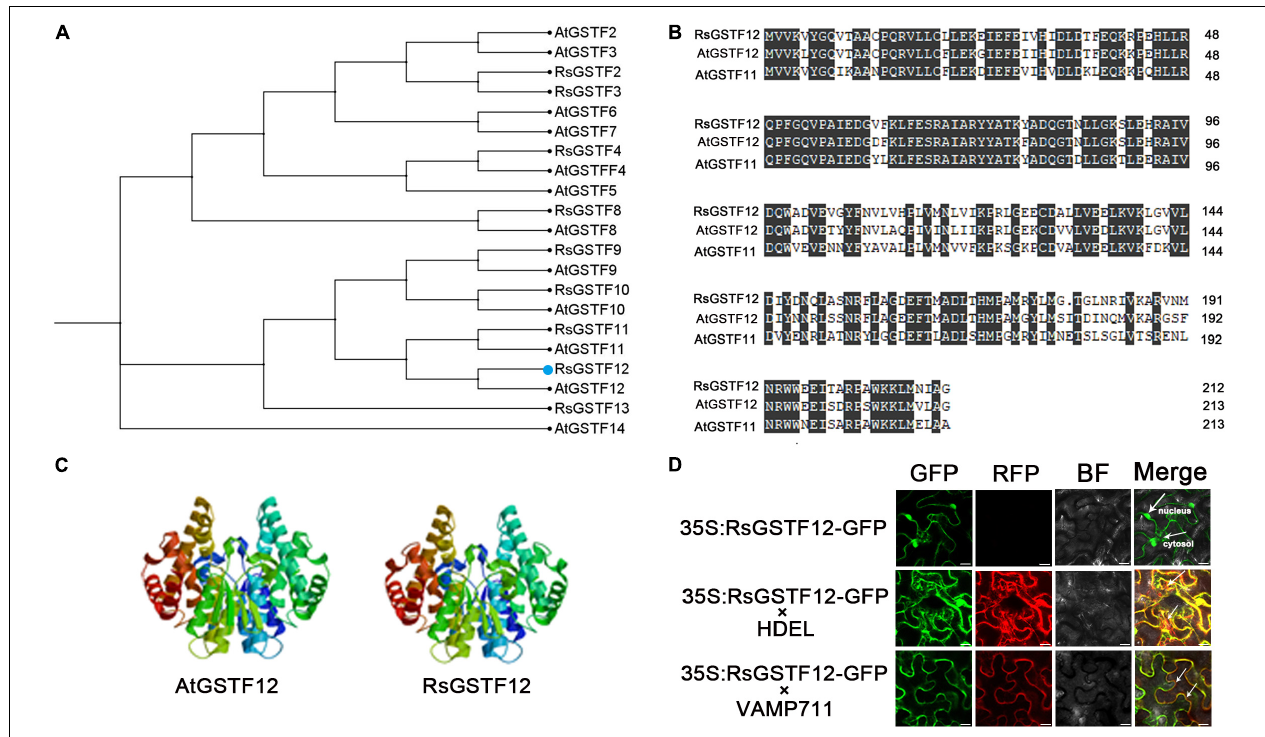
FIGURE 2 | Bioinformatics analysis and subcellular localization of RsGSTF12. (A) Phylogenetic tree analysis of RsGSTF12 and some other GSTFs in radish and Arabidopsis. (B) Amino acid sequence alignment between RsGSTF12, AtGSTF12, and AtGSTF11. (C) The prognostic three-dimensional model predictions of RsGSTF12 and AtGSTF12. (D) The subcellular localization of RsGSTF12. Epidermal cells of tobacco leaves expressing RsGSTF12:GFP with or without endoplasmic reticulum-located (HDEL-RFP) and tonoplast-located (VAMP711-RFP) markers, respectively. Scale bar = 20 µ